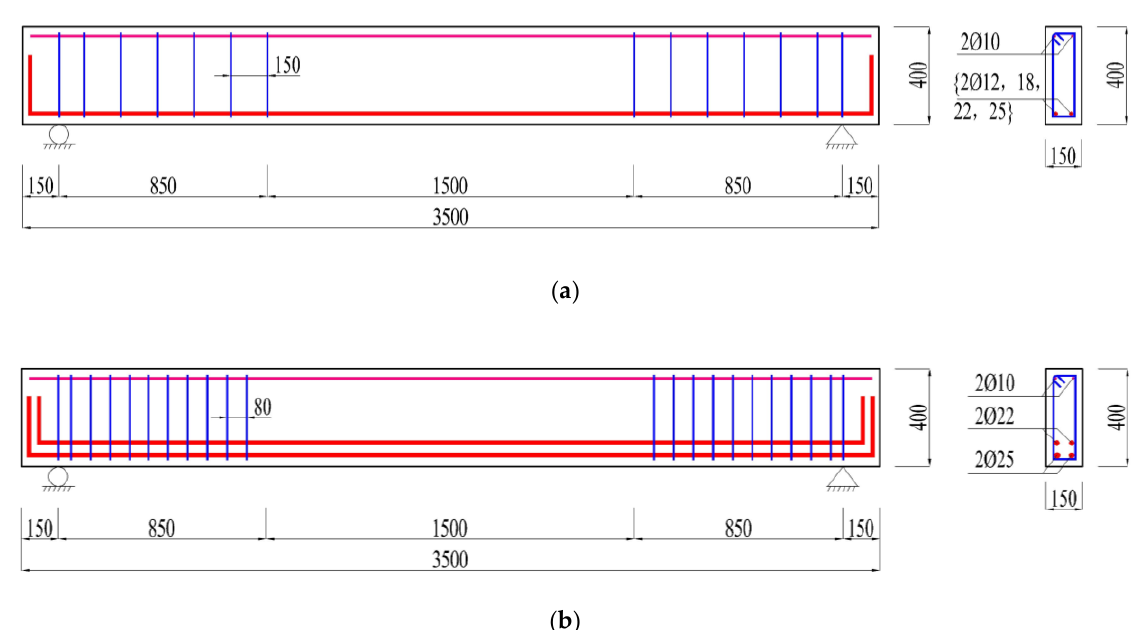
Figure 1 . Details of test beams: ( a ) with single row of rebars; ( b ) with two rows of rebars; (Unit: mm).